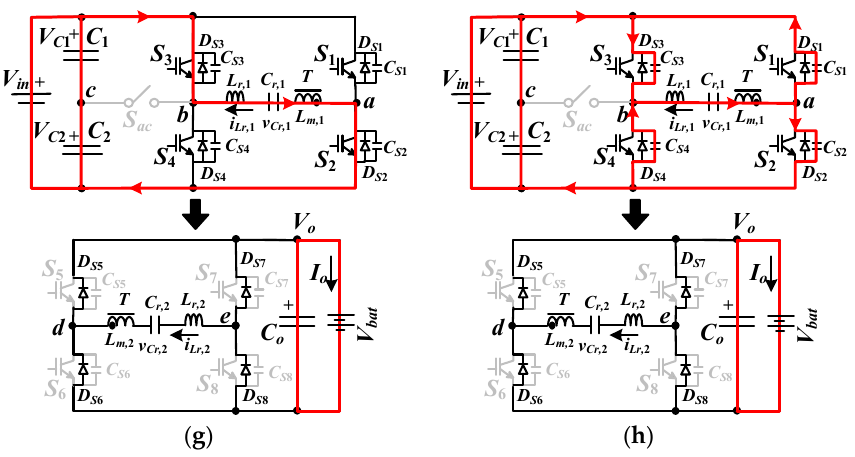
Figure 6. Equivalent circuits under high-output voltage range and forward power operation: ( a ) state 1; ( b ) state 2; ( c ) state 3; ( d ) state 4; ( e ) state 5; ( f ) state 6; ( g ) state 7; ( h ) state 8.